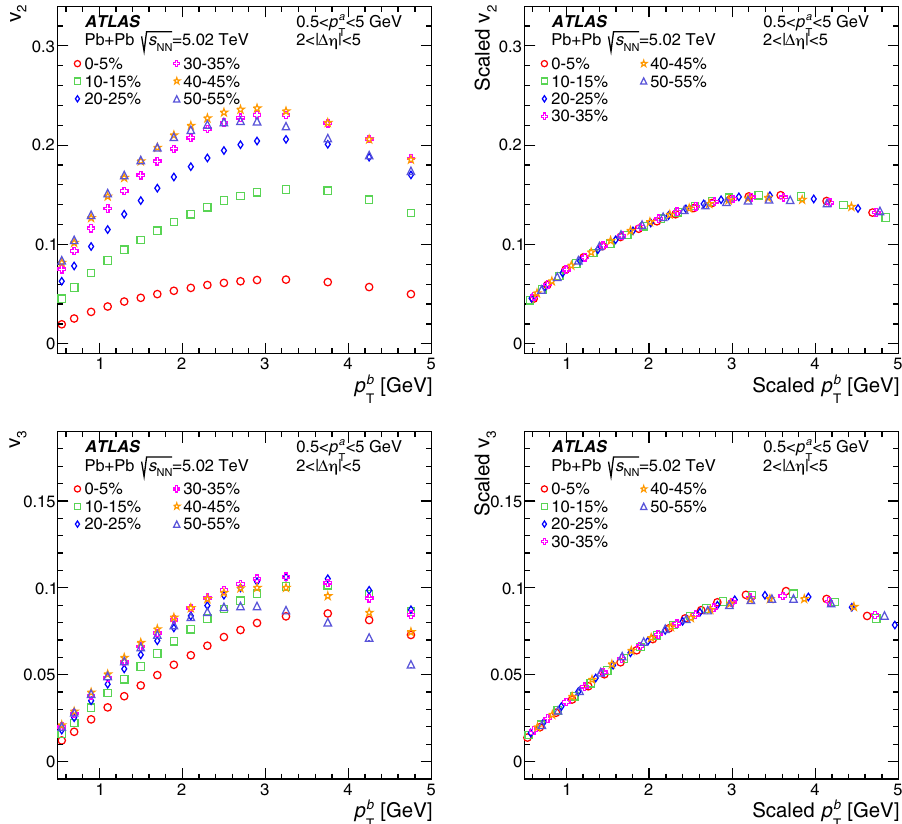
Fig. 13 Left panels: the v 2 ( p T ) (top) and v 3 ( p T ) (bottom) for different centrality intervals. Right panels: the corresponding scaled- v n ( p T ) . The error bars indicate statistical and systematic uncertainties